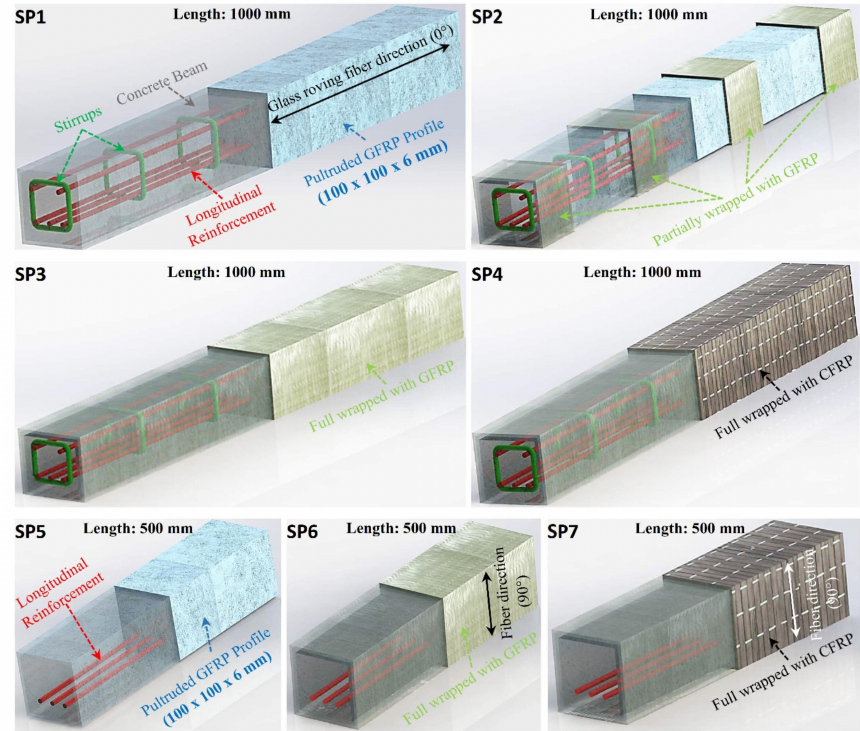
Figure 4. Test specimens and details of specimens.